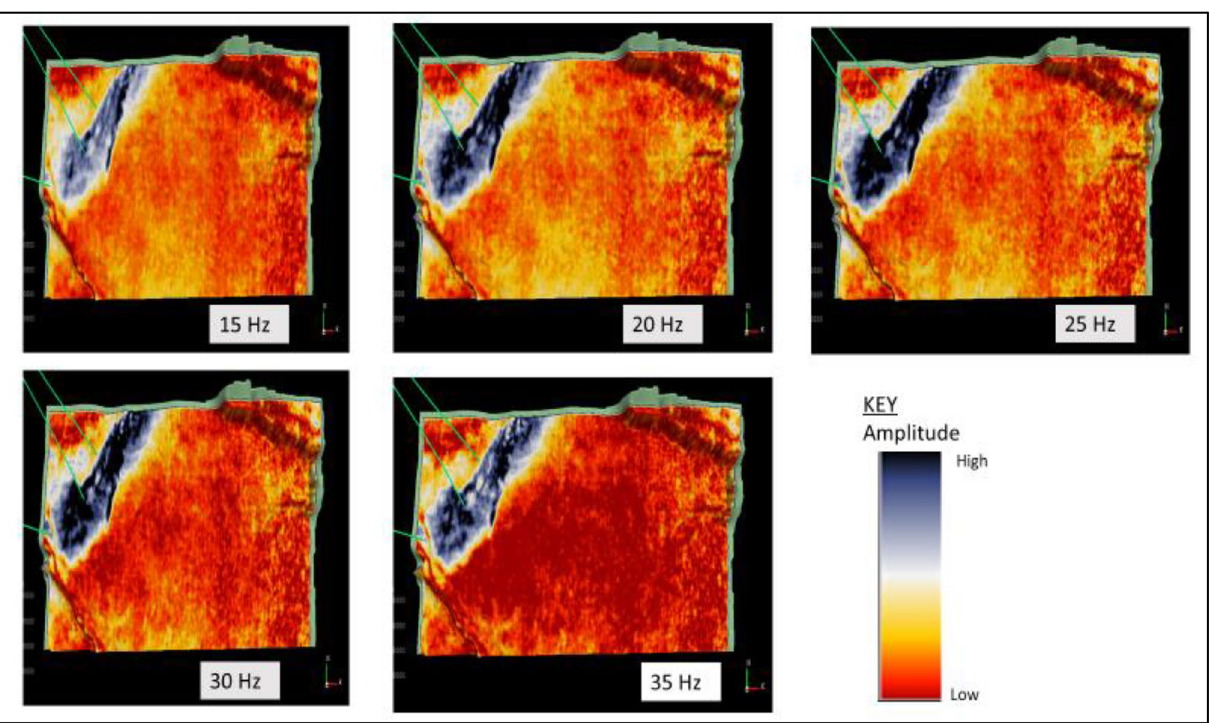
Fig. 11 Spectral frequency attribute slices, 15–35 Hz along H4